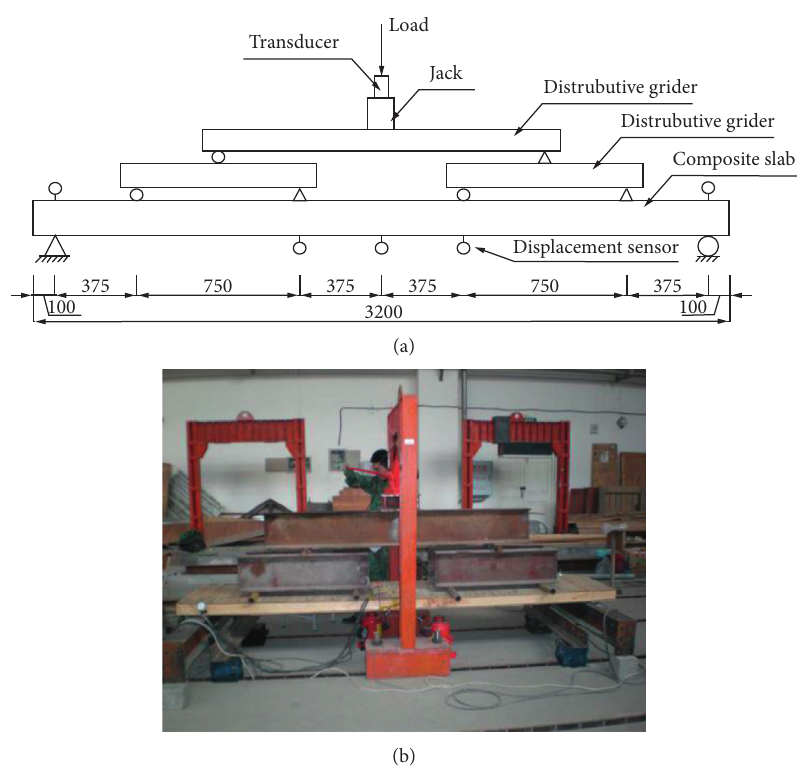
Figure 7: Eight points bending test. (a) Diagrammatic view. (b) Photograph.